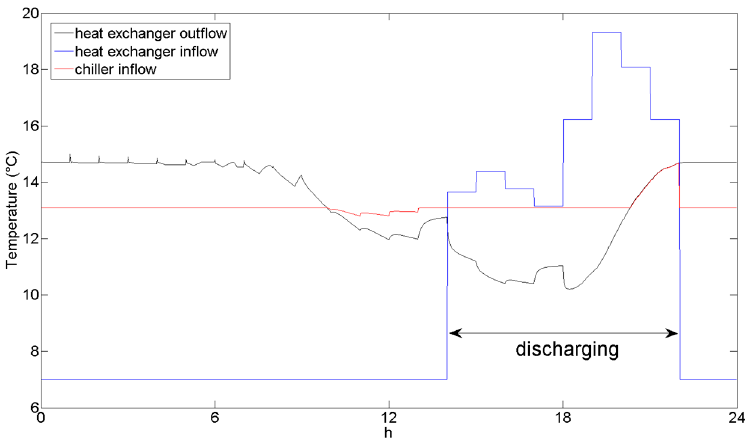
Figure 10. HTF temperature profiles at the water tank heat exchanger inflow and outflow sections, and at the chiller inflow section.